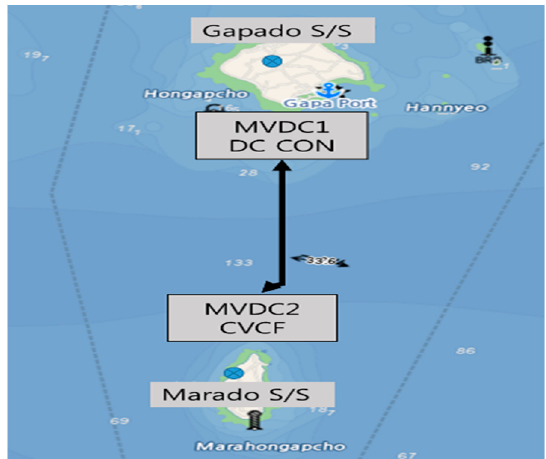
Figure 4. The proposed MVDC connection between Gapado Island and Marado Island.